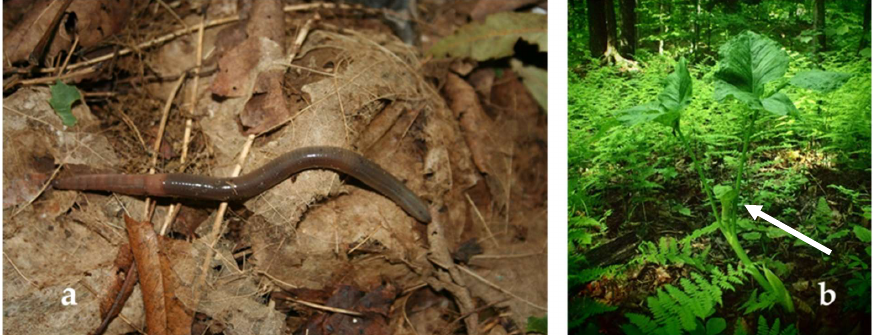
Figure 2. ( a ): Amynthas agrestis on the forest floor of a sugar maple stand at UVM’s Horticultural Research Center in South Burlington, VT, and ( b ) jack-in-the-pulpit with large leaves in a sugar maple stand in the Champlain Valley, VT, USA. Arrow pointing at the inflorescence of the